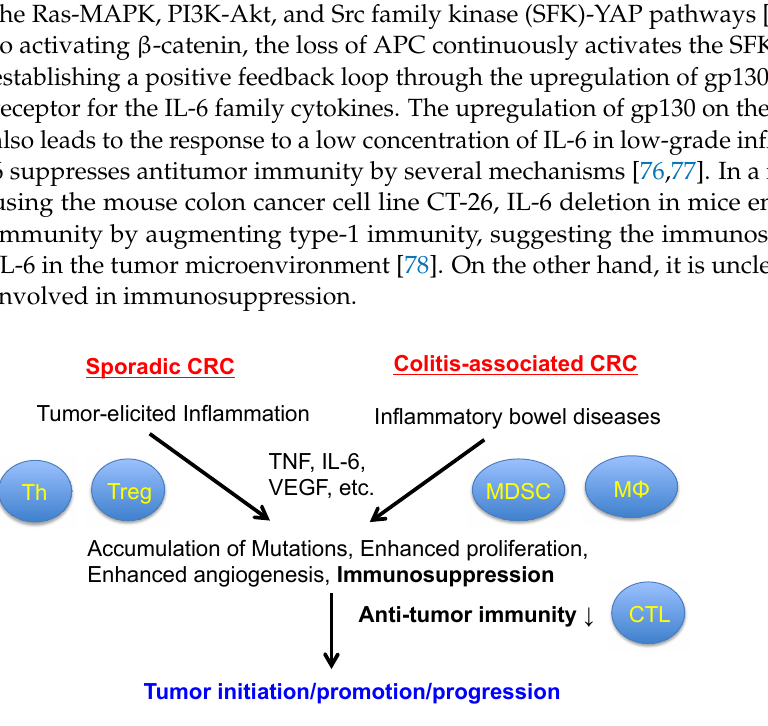
Figure 2. The role of inflammation in colorectal tumorigenesis.